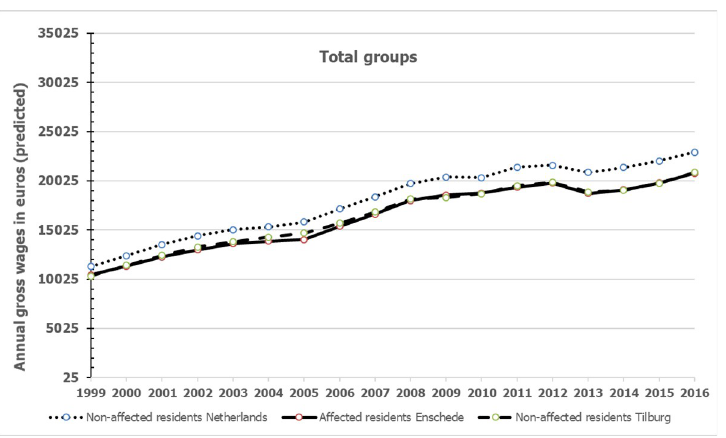
Fig 1. Gross annual mean wages of the total group of affected residents and the non-affected control groups.